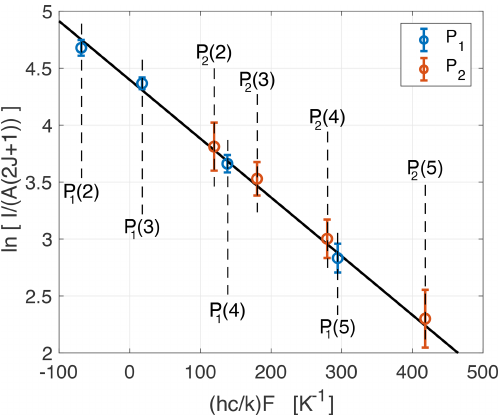
Figure 3. Boltzmann plot determined from the OH(8-3) P-branch lines shown in the HiTIES spectrum from Fig. 2, taken on the 15 December 2015 at 01:40UT with an integration time of 2min. The solid black line is a linear fit to the P 1 lines (shown as blue circles); the inverse of the slope gives a rotational temperature of 193.9K. Errors on the OH intensities I are obtained from the resid- uals of the spectral